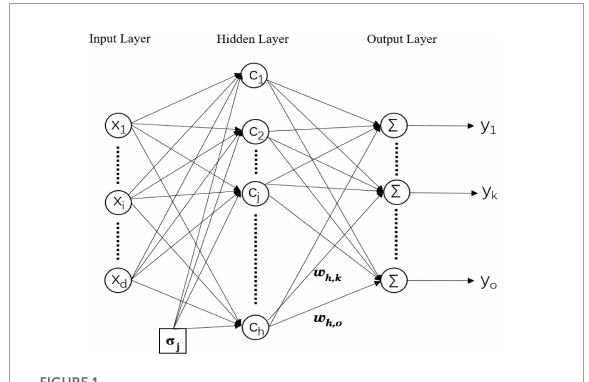
FIGURE1 Multiple-input multiple-output radial basis function neural network (RBFNN).